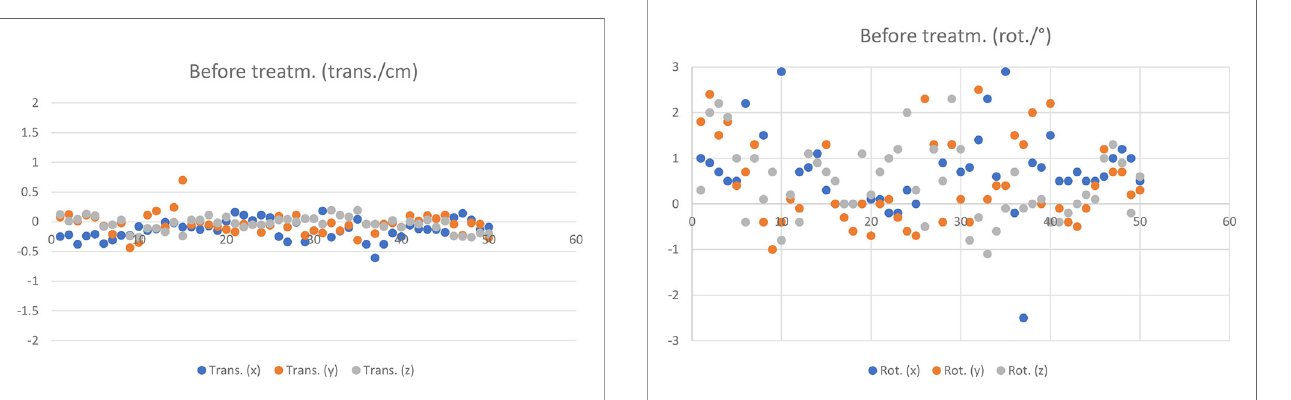
FIGURE 3 | Translational CBCT values recorded in 50 cases before treatment. FIGURE 4 | Rotational CBCT values recorded in 50 cases before